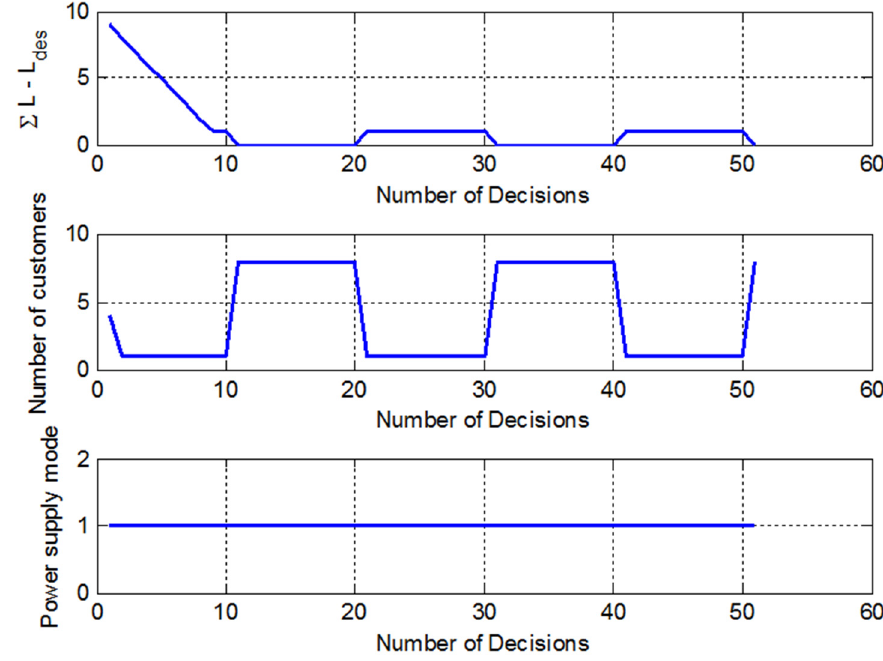
Figure 10. Desired